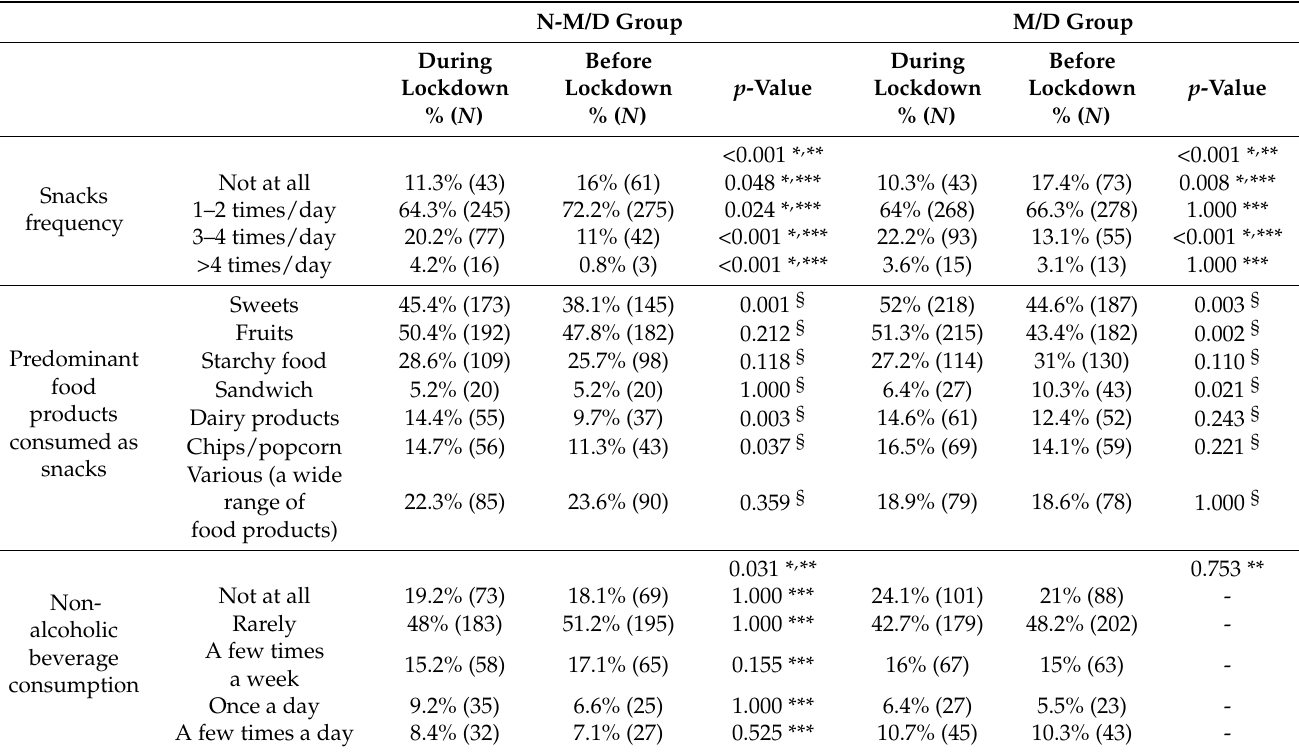
Table 2. Eating habits changes between pre-lockdown and during the COVID-19 lockdown, among medical/dental professionals and the general